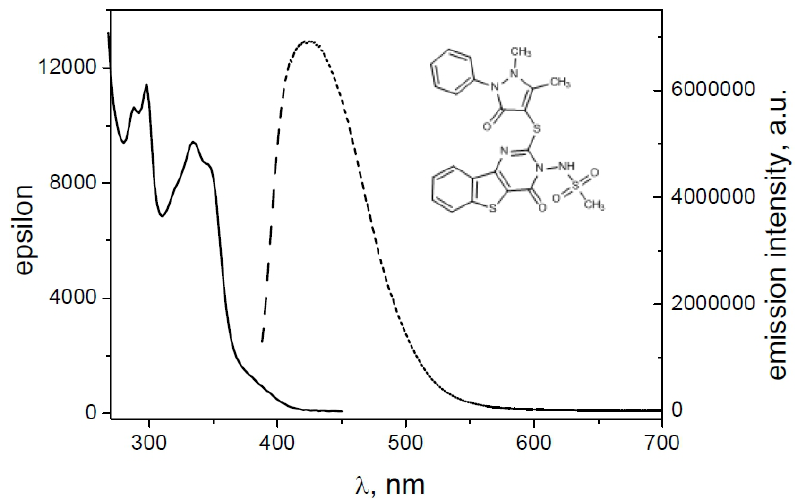
Figure 9. Absorbance (straight line) and emission (dashed line) of 4 .